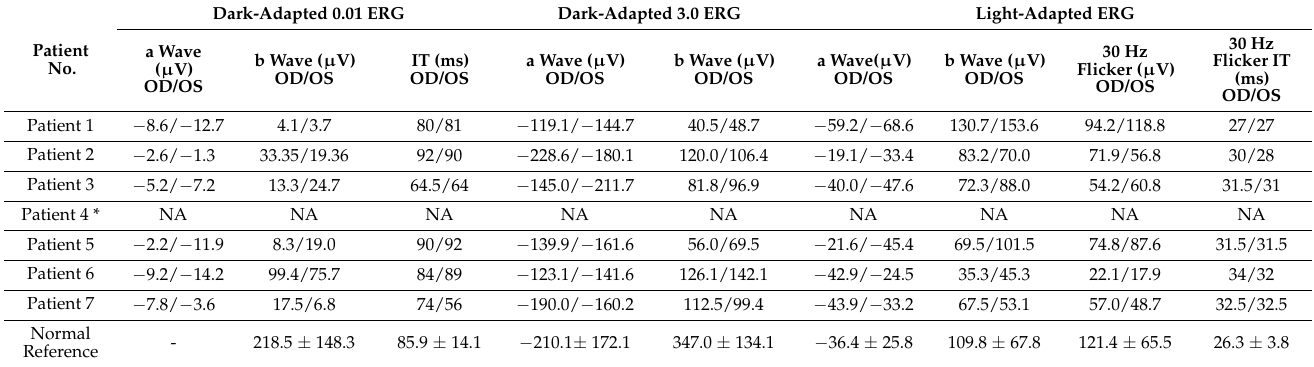
Table 3. Summary of the full field electroretinogram (ff-ERG) results of our patients diagnosed with congenital stationary night blindness